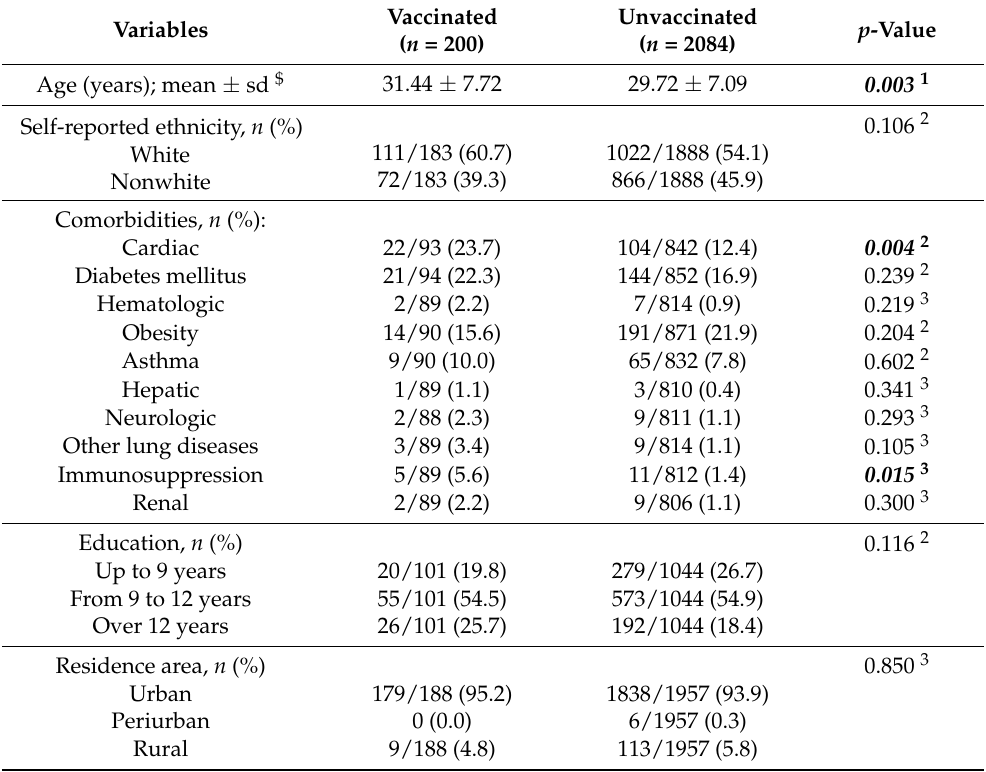
Table 1. Baseline characteristics of subjects according to vaccination status.